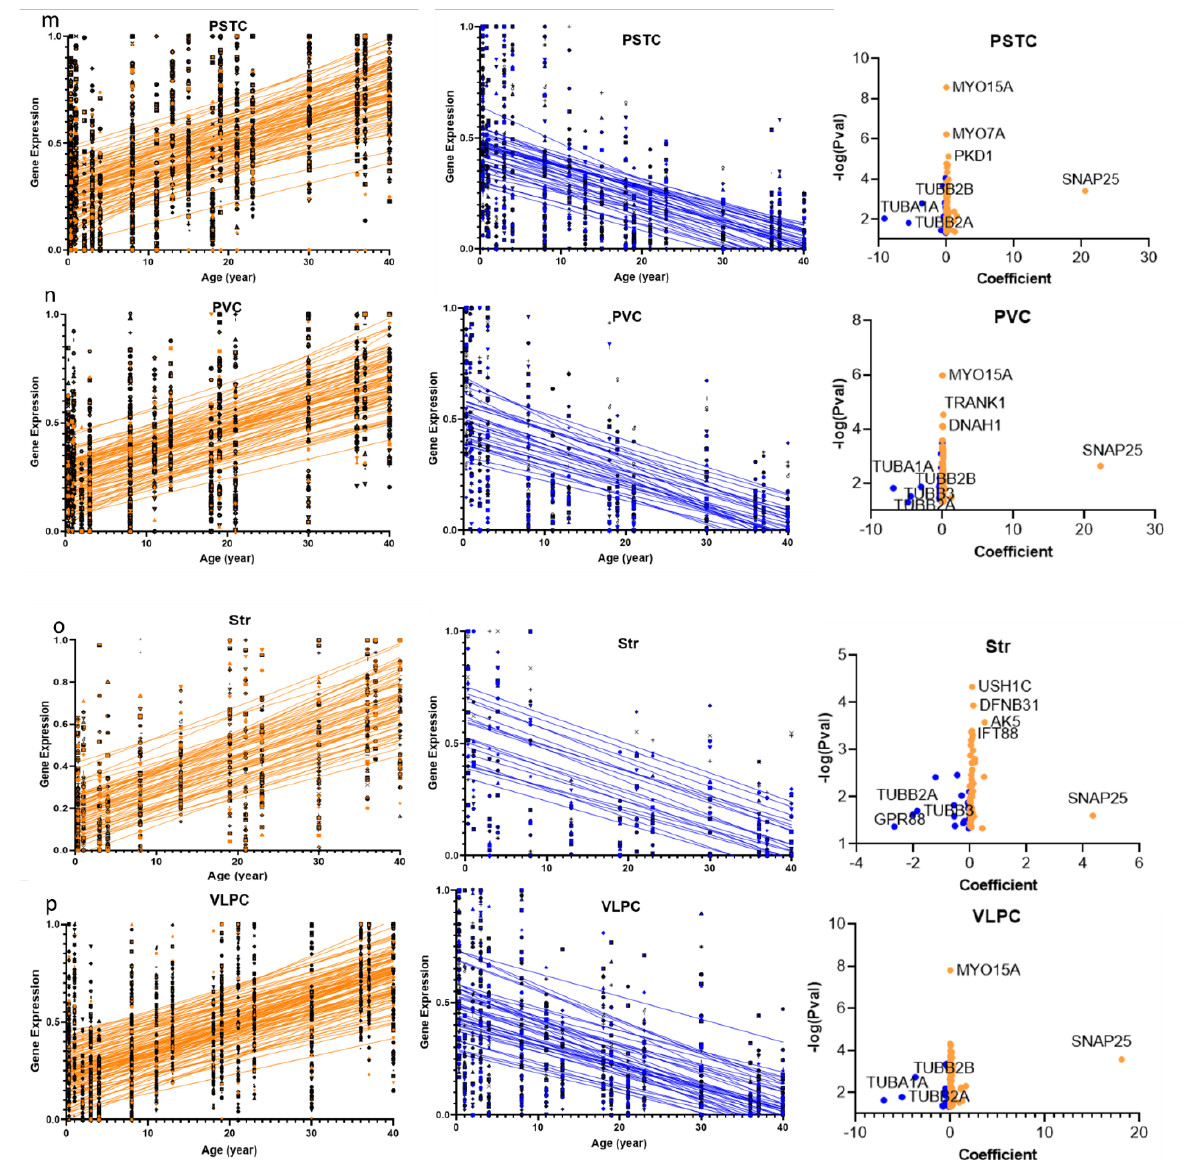
Figure 2. Linear regression model fitting the effect of age on cilia gene expression in 16 human brain regions. ( a – p ): scatter plots of gene expression patterns of cilia genes that are differentially expressed with age (cilia DEGAs) in each of the 16 human brain regions. ( Left panels ): Age-dependent upregulated cilia DEGAs in brain regions. ( Middle panels ): Age-dependent downregulated cilia DEGAs in brain regions. ( Right panels ): Volcano plot of regression coefficients and p -values in brain regions. The x-axis is the age effect on cilia gene expression of cilia DEGAs measured by regression coefficient. The y-axis represents the −log10 ( p -value). The larger −log10 ( p -value) value, the more significance. The orange dots represent age-dependent upregulated cilia DEGAs and the blue dots represent age-dependent downregulated cilia DEGAs.